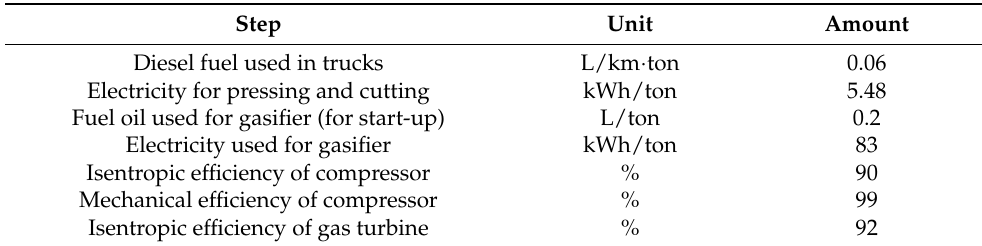
Table 1. Some assumption for energy and efficiency inputs